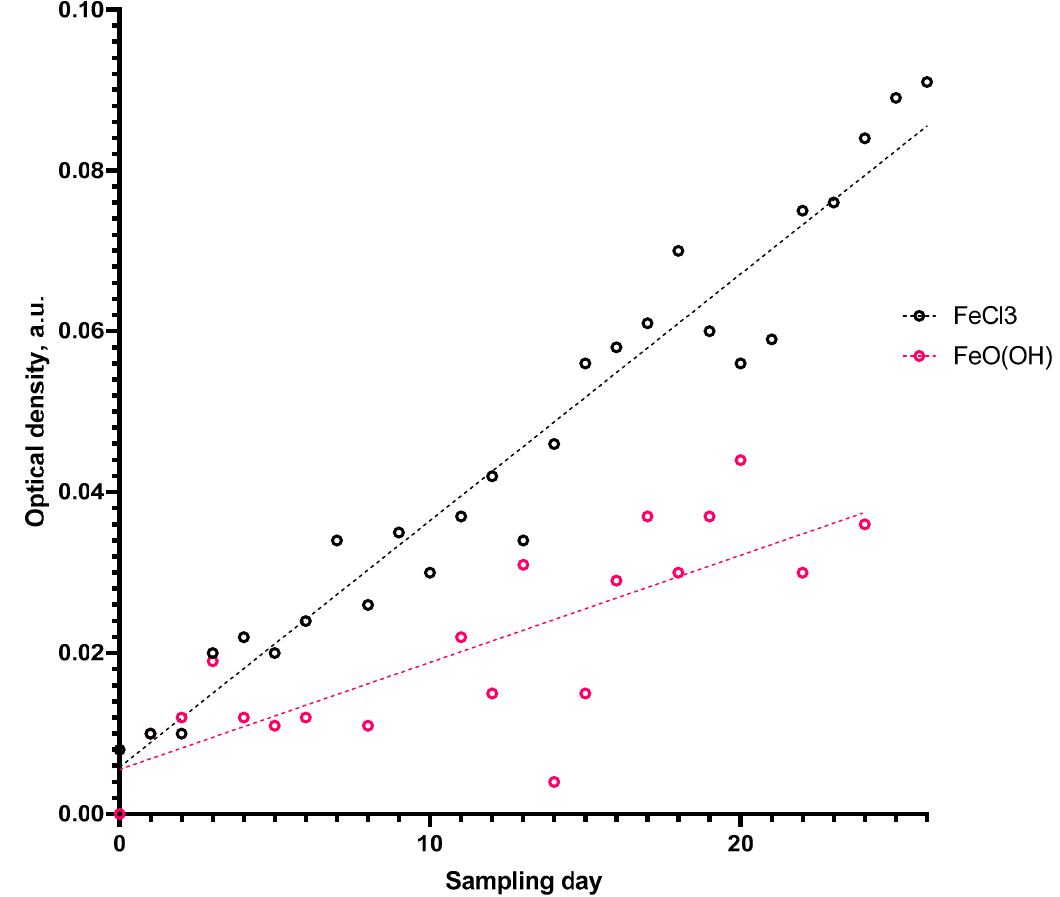
Figure 1. Optical density at 730 nm as a measure of growth of Synechococcus grown on an Aquil medium supplied with FeCl 3 (black) and FeO(OH) (red), with simple regression curves shown.